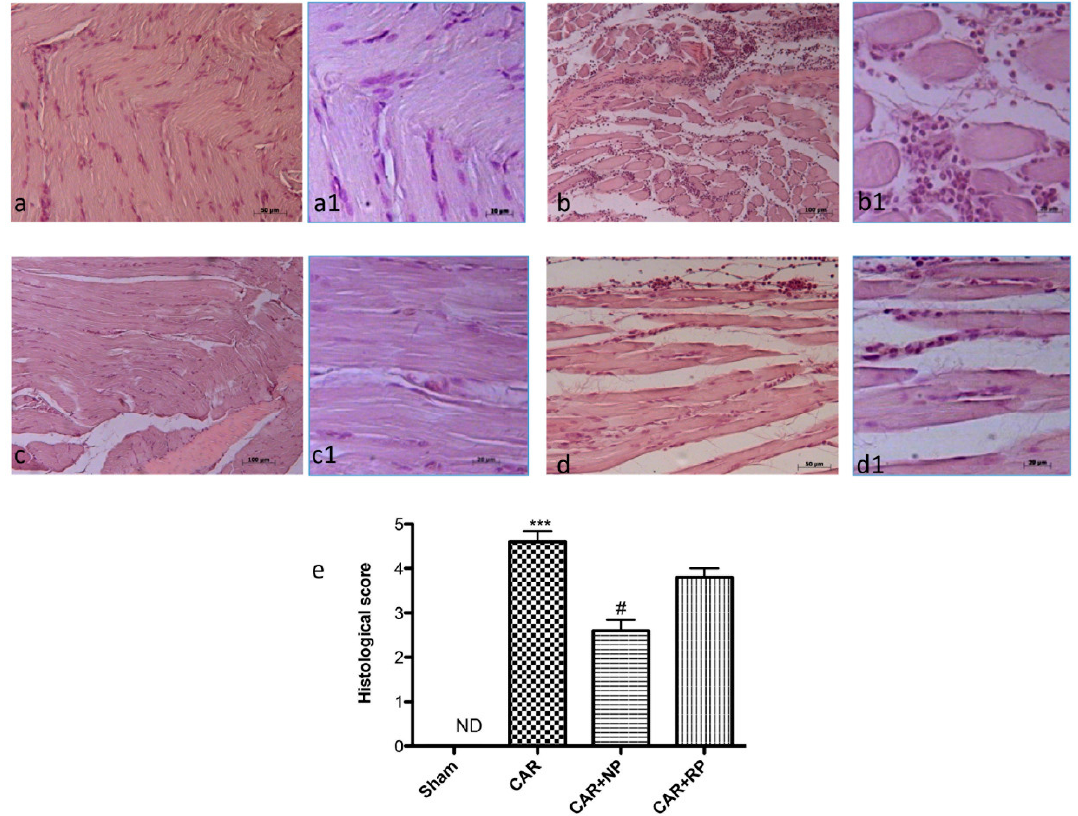
Figure 6. Anti-inflammatory effects of NP histological analysis. Histological evaluation was performed by hematoxylin and eosin staining: ( a ) the control group; ( b ) the intraplantar CAR injection; ( c , d ) CAR with NP treatment and CAR with RP treatment, respectively; ( a1 – d1 ) low magnification of the respective panels; and ( e ) histological score for the various treatment groups. The figures are representative of at least three independent experiments. *** p < 0.001 vs. Sham; # p < 0.05 vs. CAR.